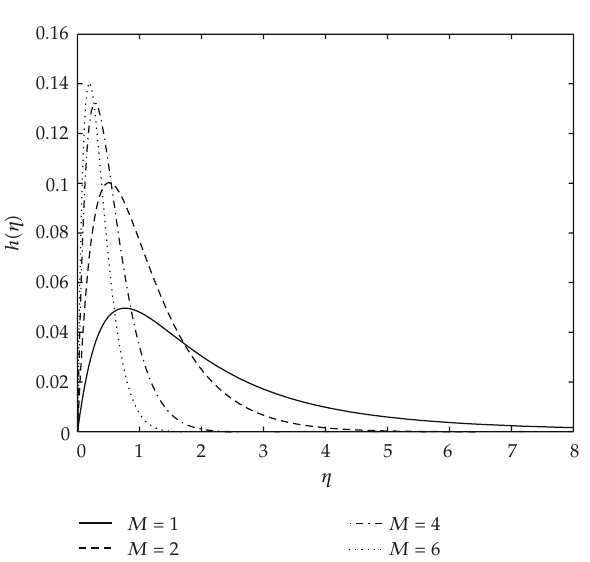
Figure 7: Transverse velocity profiles for various values of M with β 1 (cid:5) 0 . 1, Pr (cid:5) 0 . 72, m (cid:5) 1, β 2 (cid:5) 0 . 1, and S (cid:5) 0 . 8 .